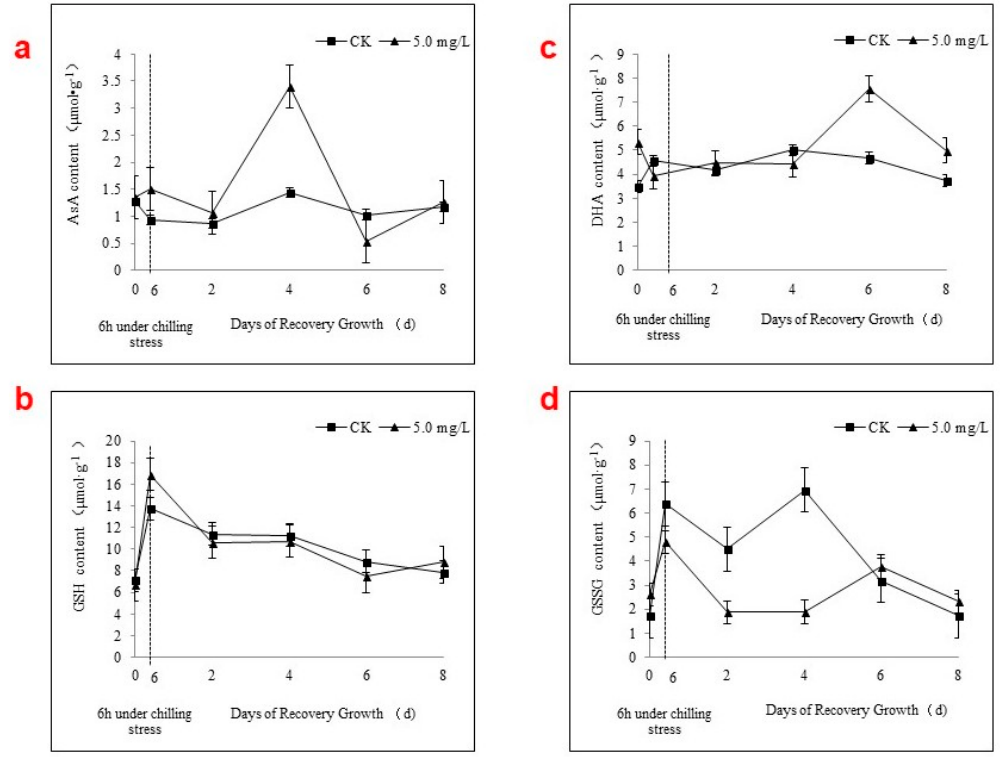
Figure 5. Effects of foliar spraying an Se solution (5 mg · L − 1 ) on the contents of low-molecular antioxidants AsA ( a ), GSH ( b ), DHA ( c ), and GSSG ( d ) in Akihime strawberry leaves during chilling stress and recovery growth.